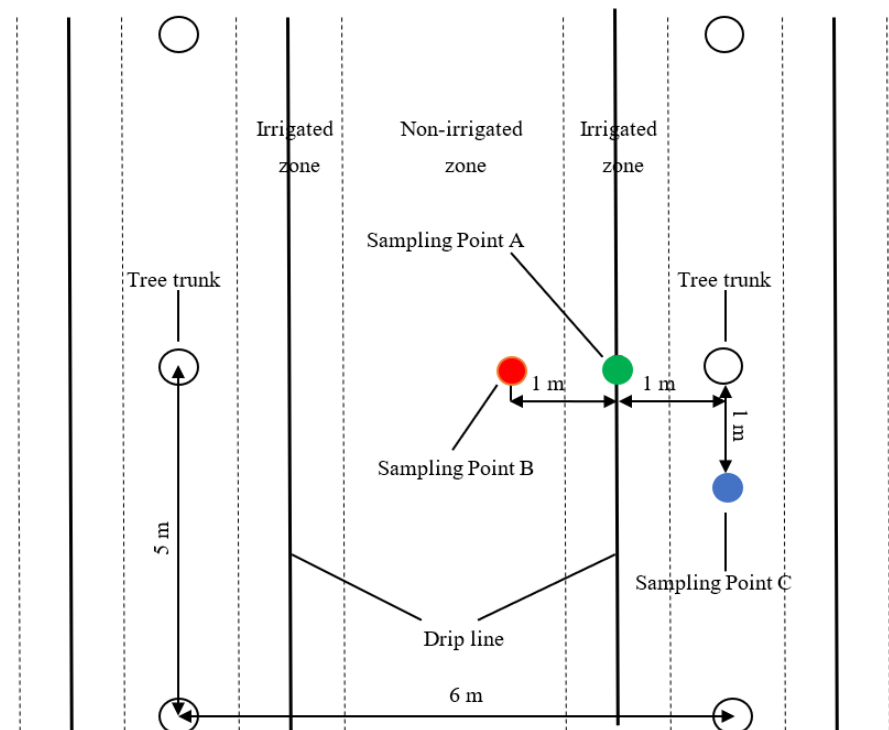
Figure 1. Sketch of root sampling and driplines layout. The sampling point A (irrigated zone) was located between tree rows and 1 m away from the trunk; the sampling point B (non ‐ irrigated zone) was located between tree rows and 2 m away from the trunk; the sampling point C (non ‐ irrigated zone) was located along the tree row and 1 m away from the trunk. Two driplines (solid line) were located on each side of the tree row, and the distance between the tree row and dripline was 1 m. The dashes lines on each side of the dripline represent the wetted zone of the dripline, with a width of 1 m.